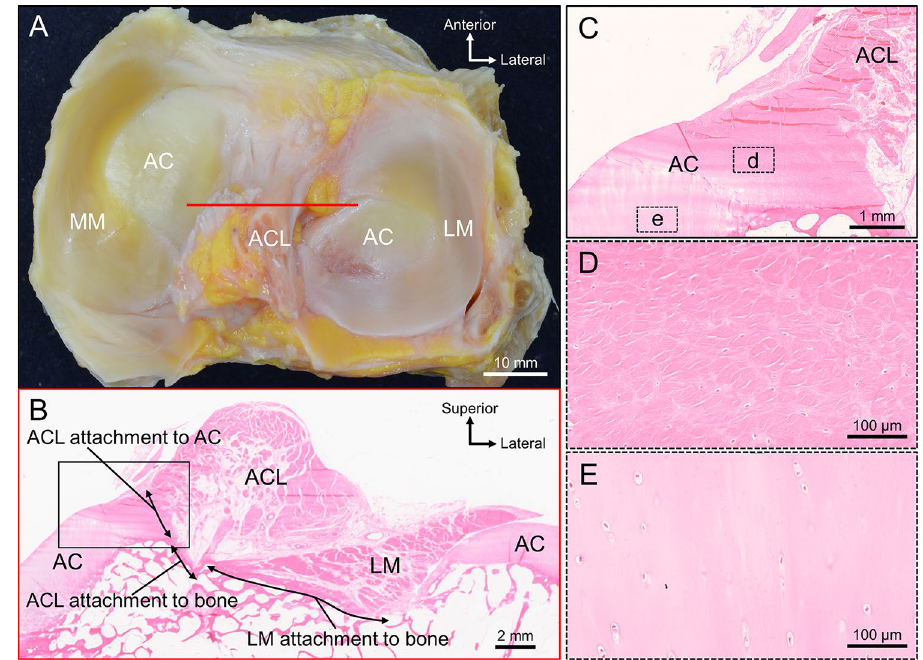
Figure 3. The attachment of ACL to the articular cartilage. ( A ) The superior aspect of the proximal side of the tibia, with the collection sites for the coronal sections indicated by a red line. ( B ) Coronal section of the red line in ( A ). The LM enters the intercondylar area from the lateral side and is broadly attached to the bone surface. ACL is narrowly attached to the bone surface, and the remaining part of the ACL is attached to the articular cartilage on the medial side. ( C ) A magnified view of the black rectangular space in ( B ). The attachment region of ACL to the articular cartilage is composed of a layer of fibrocartilage similar to the attachment region of ACL to the bone. ( D ) A magnified view of the fibrocartilage in ( C ). ( E ) A magnified view of the hyaline cartilage in ( C ). AC, articular cartilage; ACL, anterior cruciate ligament; LM, lateral meniscus; MM, medial meniscus.